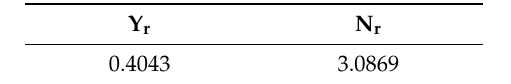
Table 10. Solving cases of coupling derivatives.